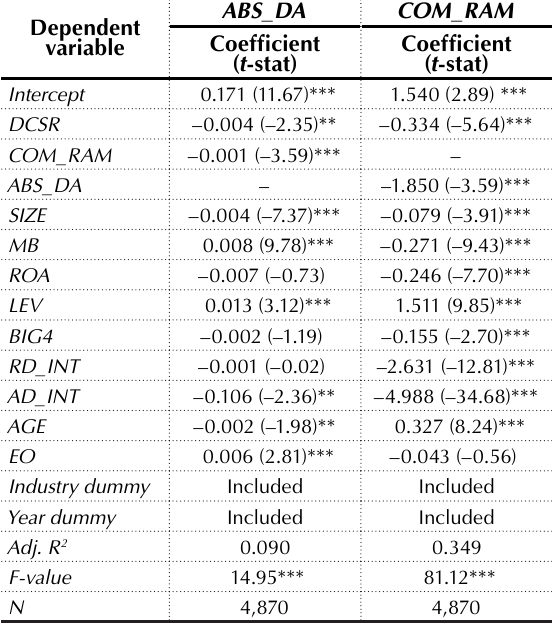
Table 4. OLS regression of earnings management